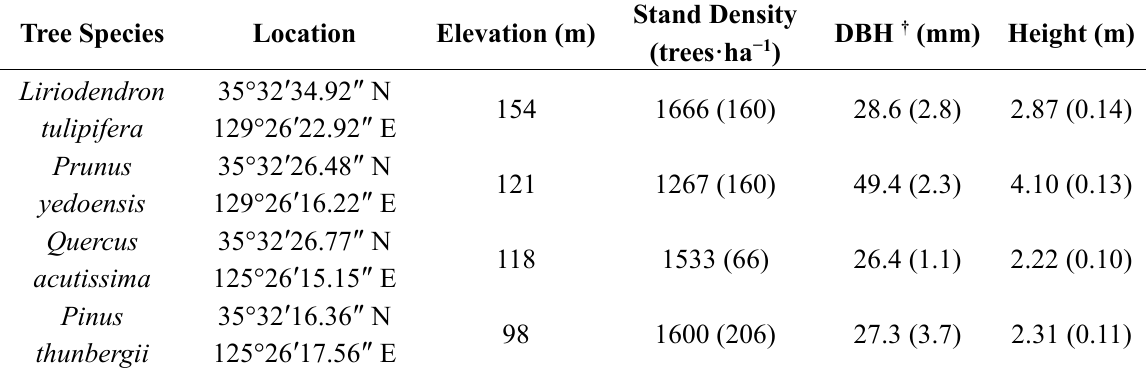
Table 1. Stand characteristics before fertilization in the study